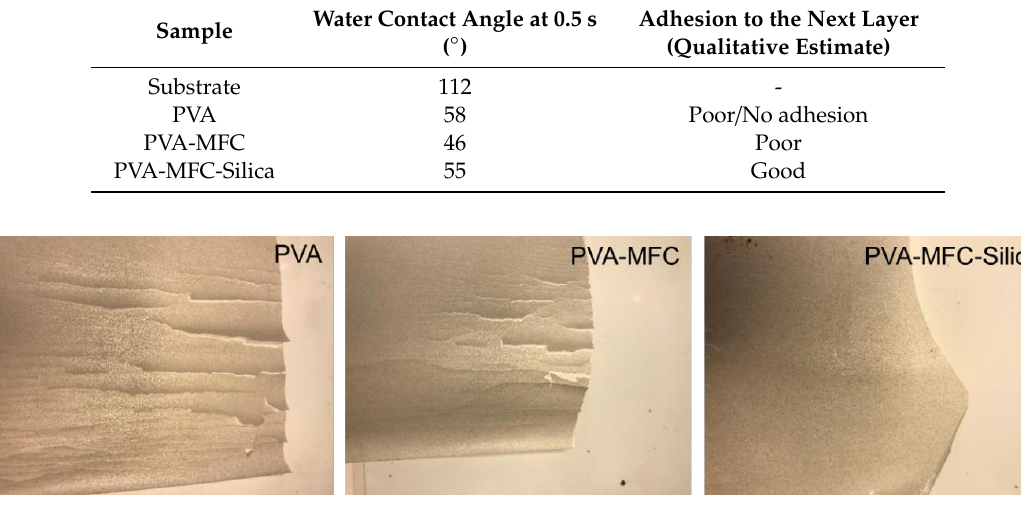
Figure 6. Coated samples after performing the adhesion test.